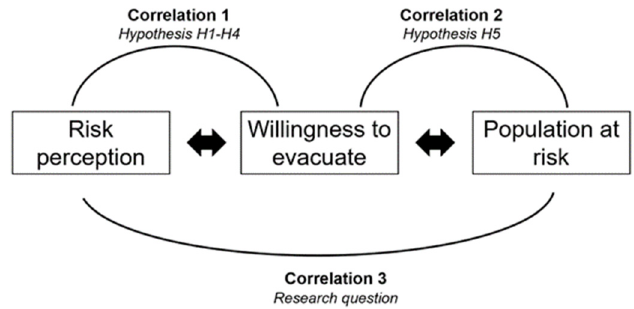
Figure 1. Research question and hypothesis.